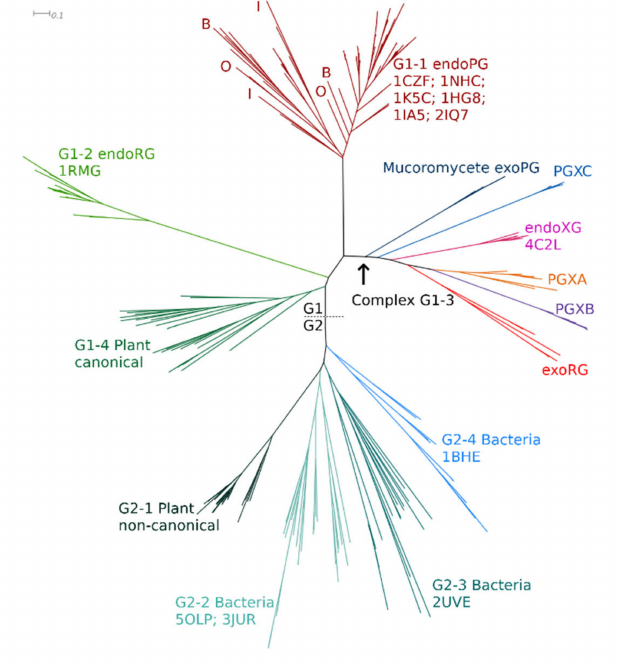
Figure 2. Phylogenetic relationship and functional/taxonomic clustering of GH28 training-set se- quences. Sequences cluster with 100% P&R in major clusters G1 and G2, which were subclustered hierarchically to find functional clusters. Different clusters have different colors, are 100% P&R and represent either a functional class or a taxon. B: basidiomycete; O: oomycete; and I: insect (approxi- mate indications), ascomycete homologues are not indicated. Sequences with resolved structures are indicated by their PDB identifier. The scale bar indicates the number of amino acid substitutions per site. The tree was constructed using the LG model, four fixed rate classes and a gamma shape parameter of